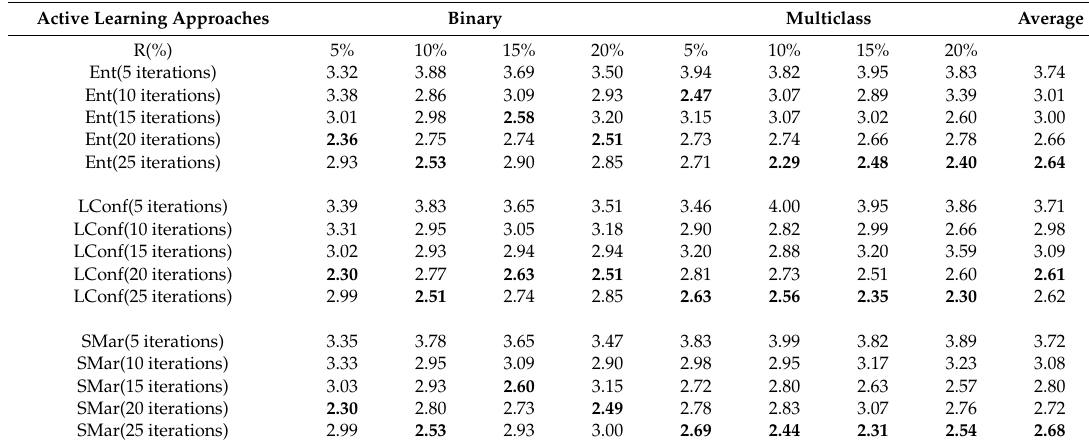
Table 10. Freidman ranking scores for hyperparameter tuning of the Logitboost scheme. Active Learning